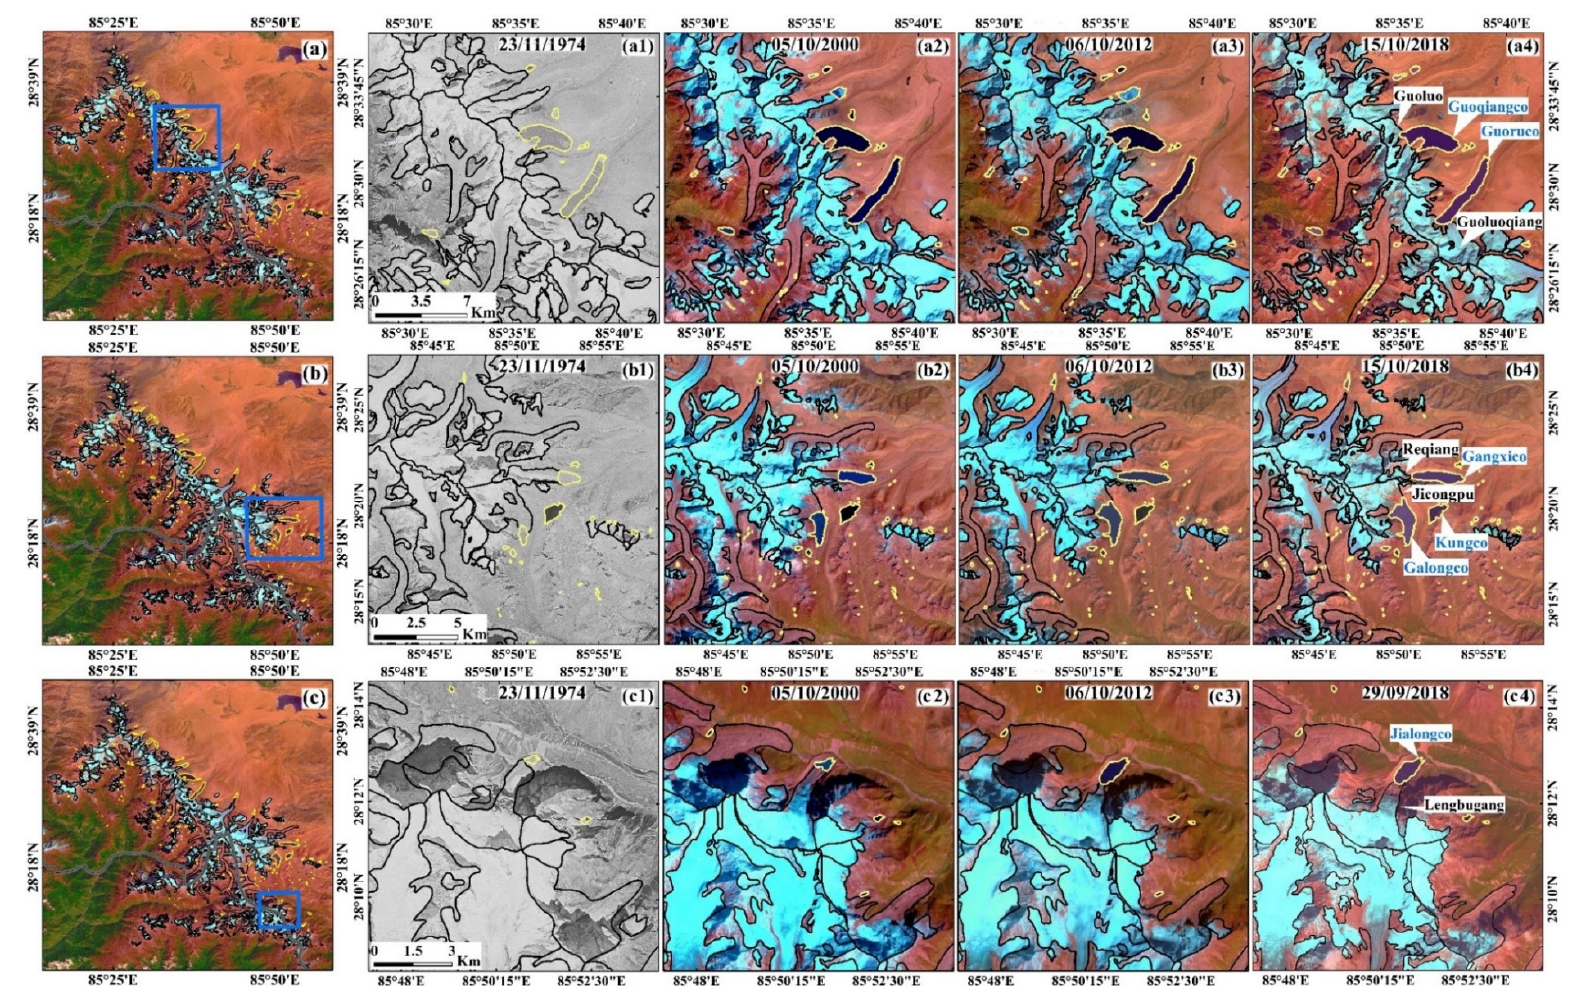
Figure 6. Changes in glacier and glacial lake area in the Xixabangma massif from 1974 to 2018. Blue rectangles in subfigures ( a – c ) denote the location of areas shown in the corresponding subfigures from the second to the fifth columns. Black and yellow curves denote the glacier and glacial lake outlines, respectively. Backgrounds in the subfigures of the second column are KH-9 images, and those in the rest are Landsat images.